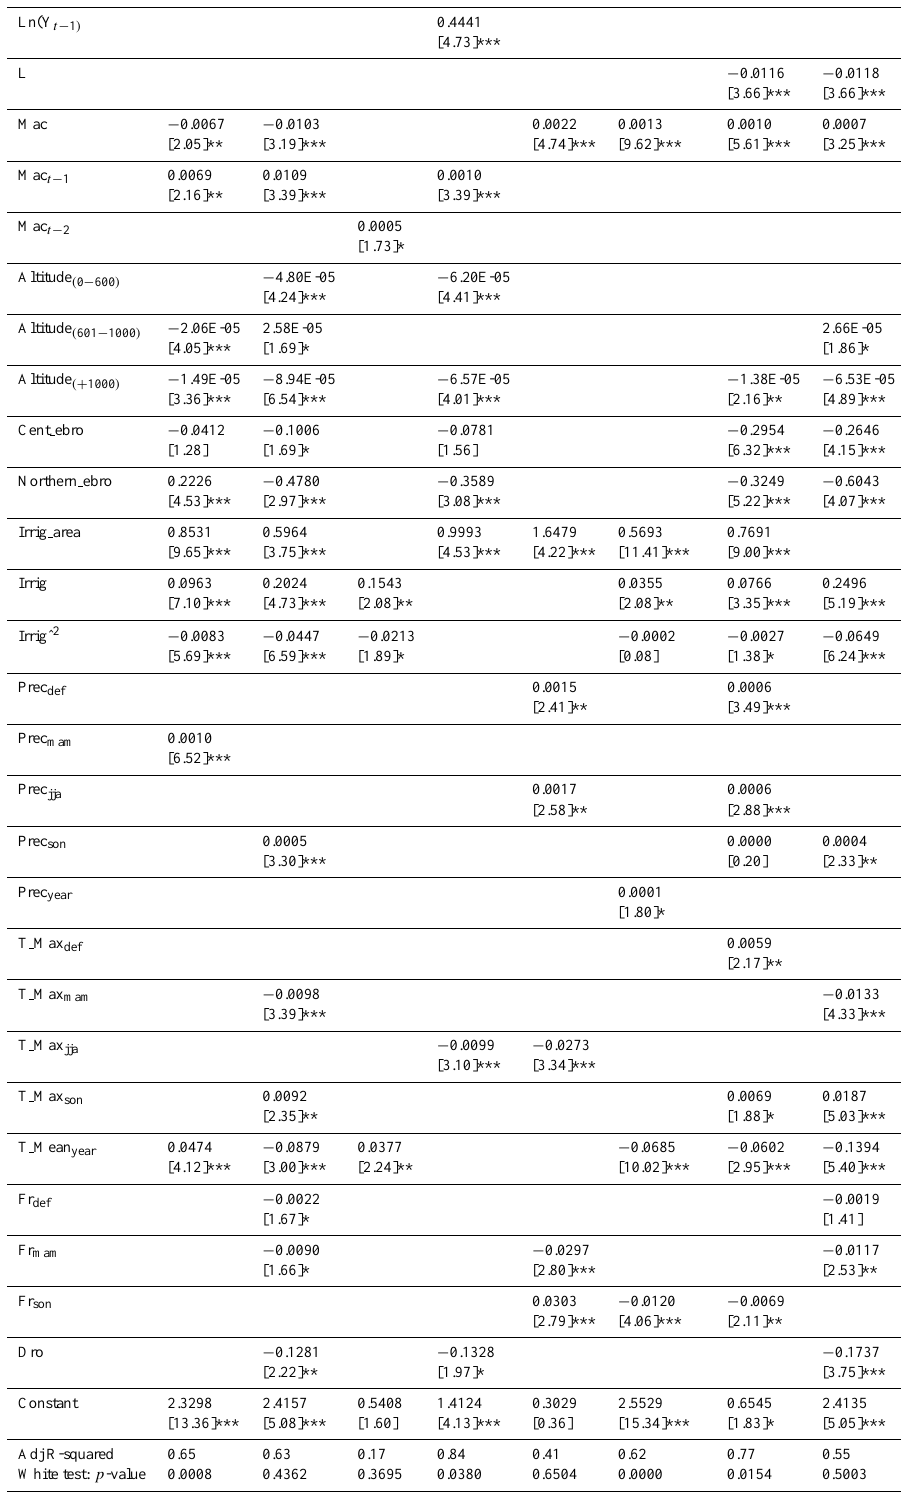
Table 5. Estimated coefficients of crop-water functions, robust t-statistics and R 2